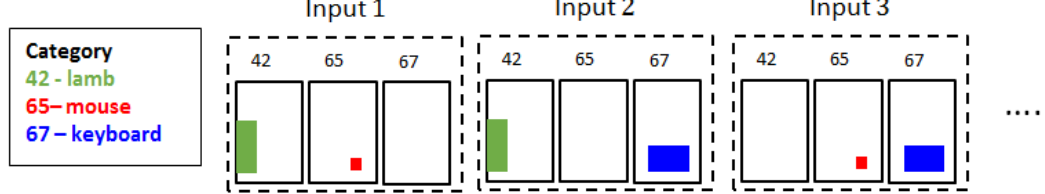
Figure 8. Generate input sets for context-learning convolutional neural networks